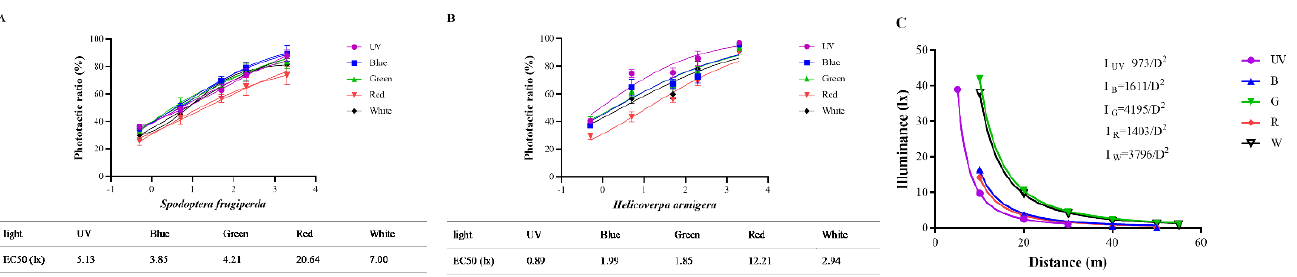
8 of 13 Figure 5. Phototactic recovery rates of S. frugiperda and H. armigera under indoor simulated condi- tions. The light intensity is 0.5 lx for three LED lights. Data are mean ± SE. Different letters of the same species indicate significant differences among different treatments ( p < 0.05, ANOVA). “*” indicates a significant difference between the two samples ( p < 0.05, t - test), while “ns” means not. 3.5. EC50 and Trapping Distances of Two Moths with Different Light Sources